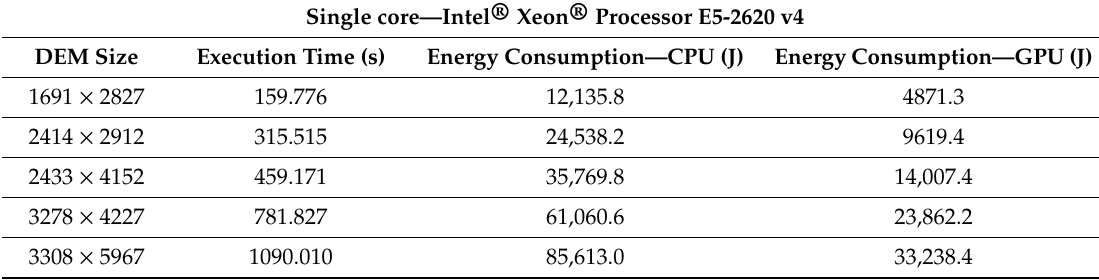
Table 5. Single core-Intel ® Xeon ® Processor E5-2620 v4.